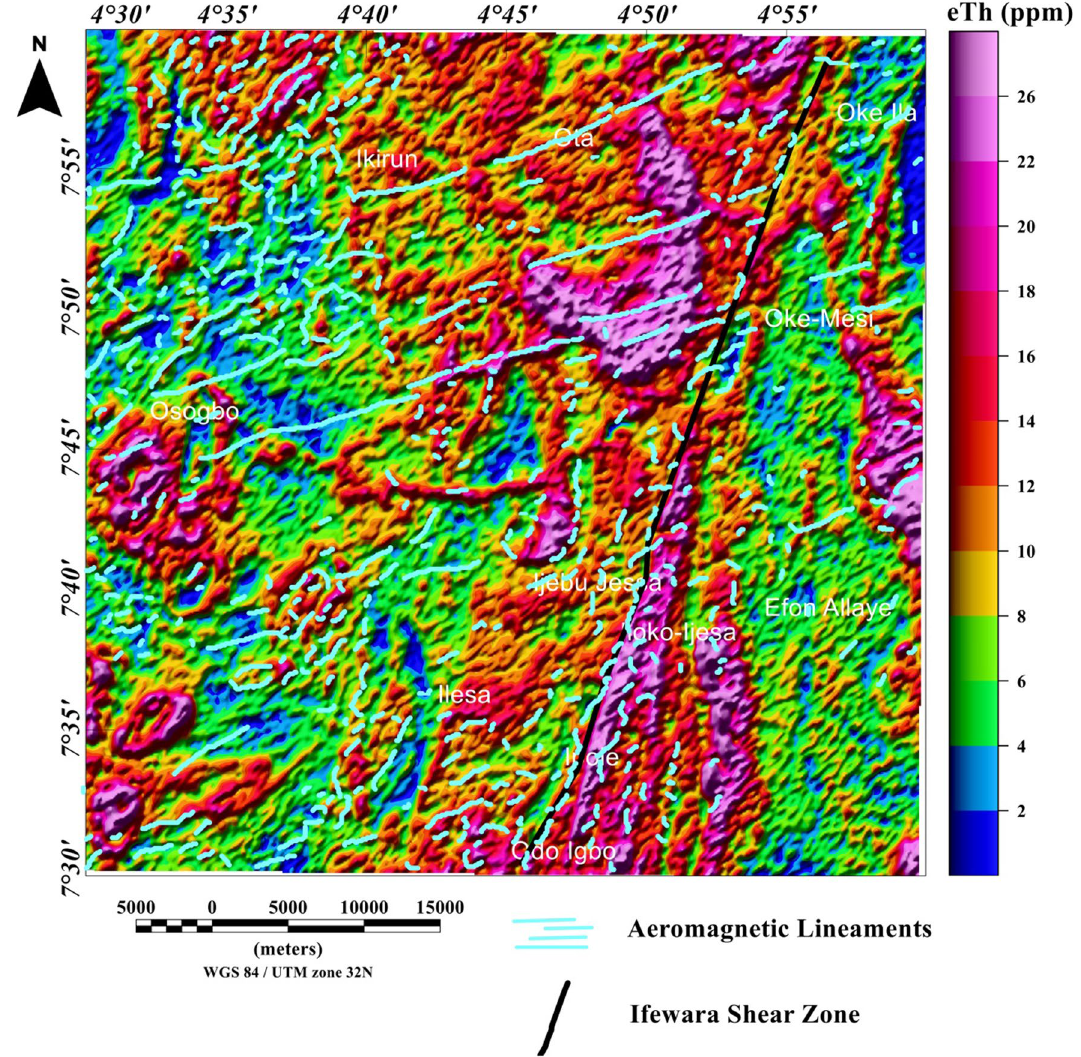
Figure 15. Map of thorium (ppm) data of the Ife-Ilesha schist belt with superimposed Ifewara fault zone extracted from the total gradient amplitude map presented in color-shaded relief, illuminated from the north- northwest direction. The north-northwest illumination (azimuth: 337.5 degrees and light angle: 45 degrees) enhances north-northeast lineaments. The figure was produced using Oasis Montaj Software version 8.3.3 (Website: https:// www. seequ ent.